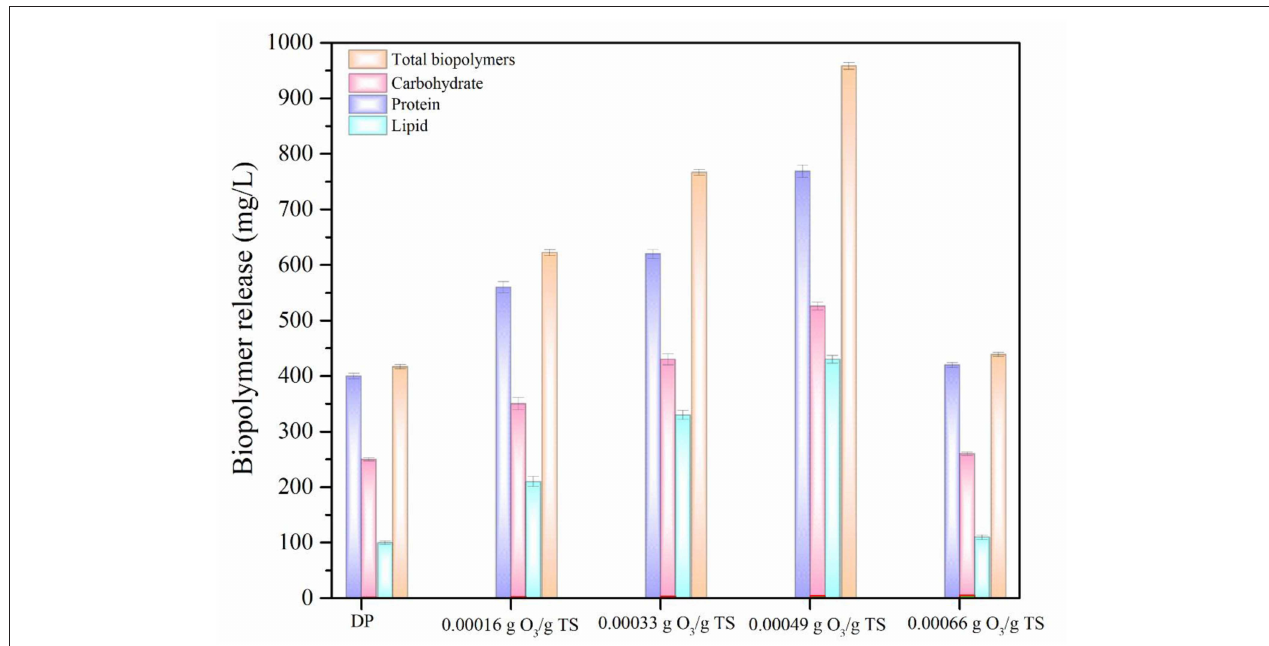
FIGURE 3 | Effect of ozone disperser pretreatment (ODP) on biopolymer release.